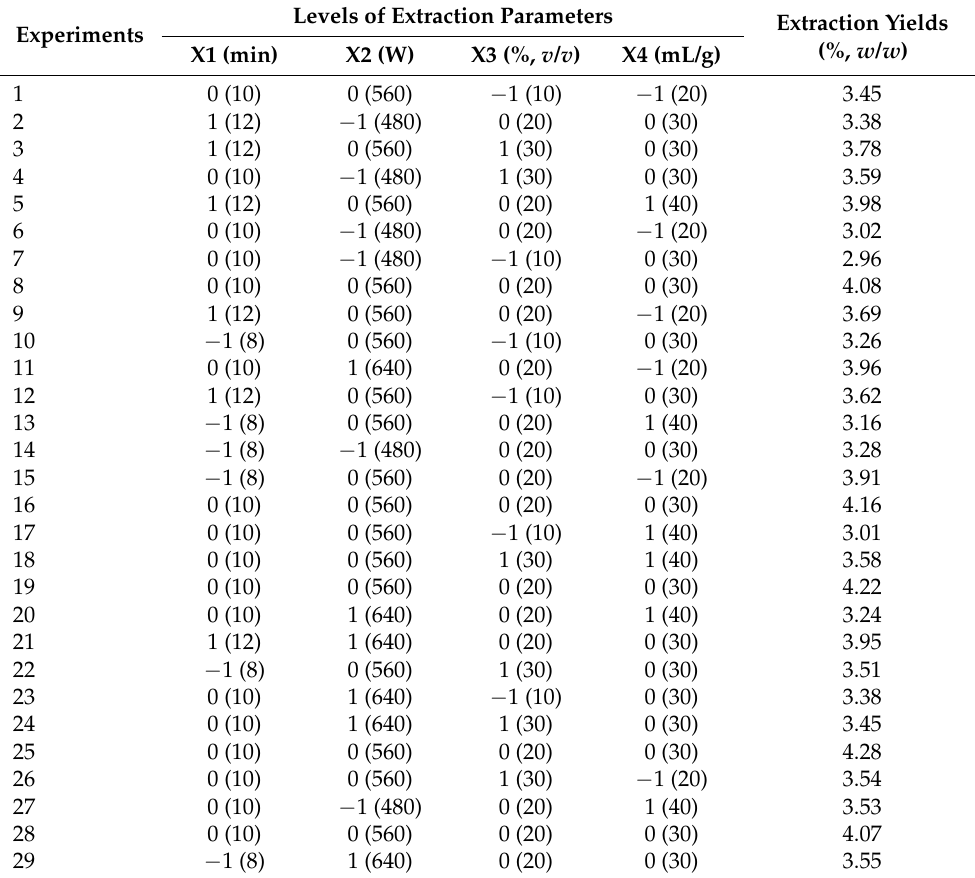
Table 1. BBD with independent variables and observed values for the yields of polysaccharides extracted from sweet tea leaves by microwave-assisted deep eutectic solvent extraction. Levels of Extraction Experiments